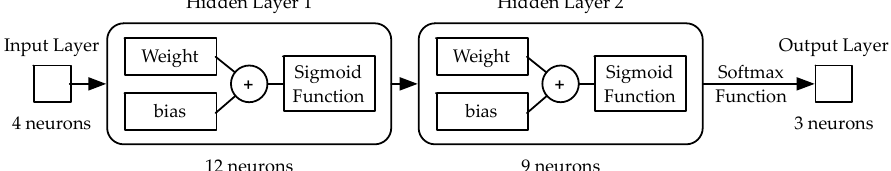
Figure 6. The structure of the multilayer feedforward neural network.